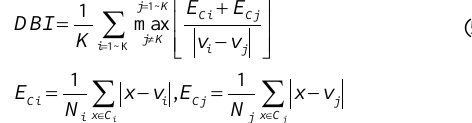
segment principle curves from discrete track points (Figure 5-b)